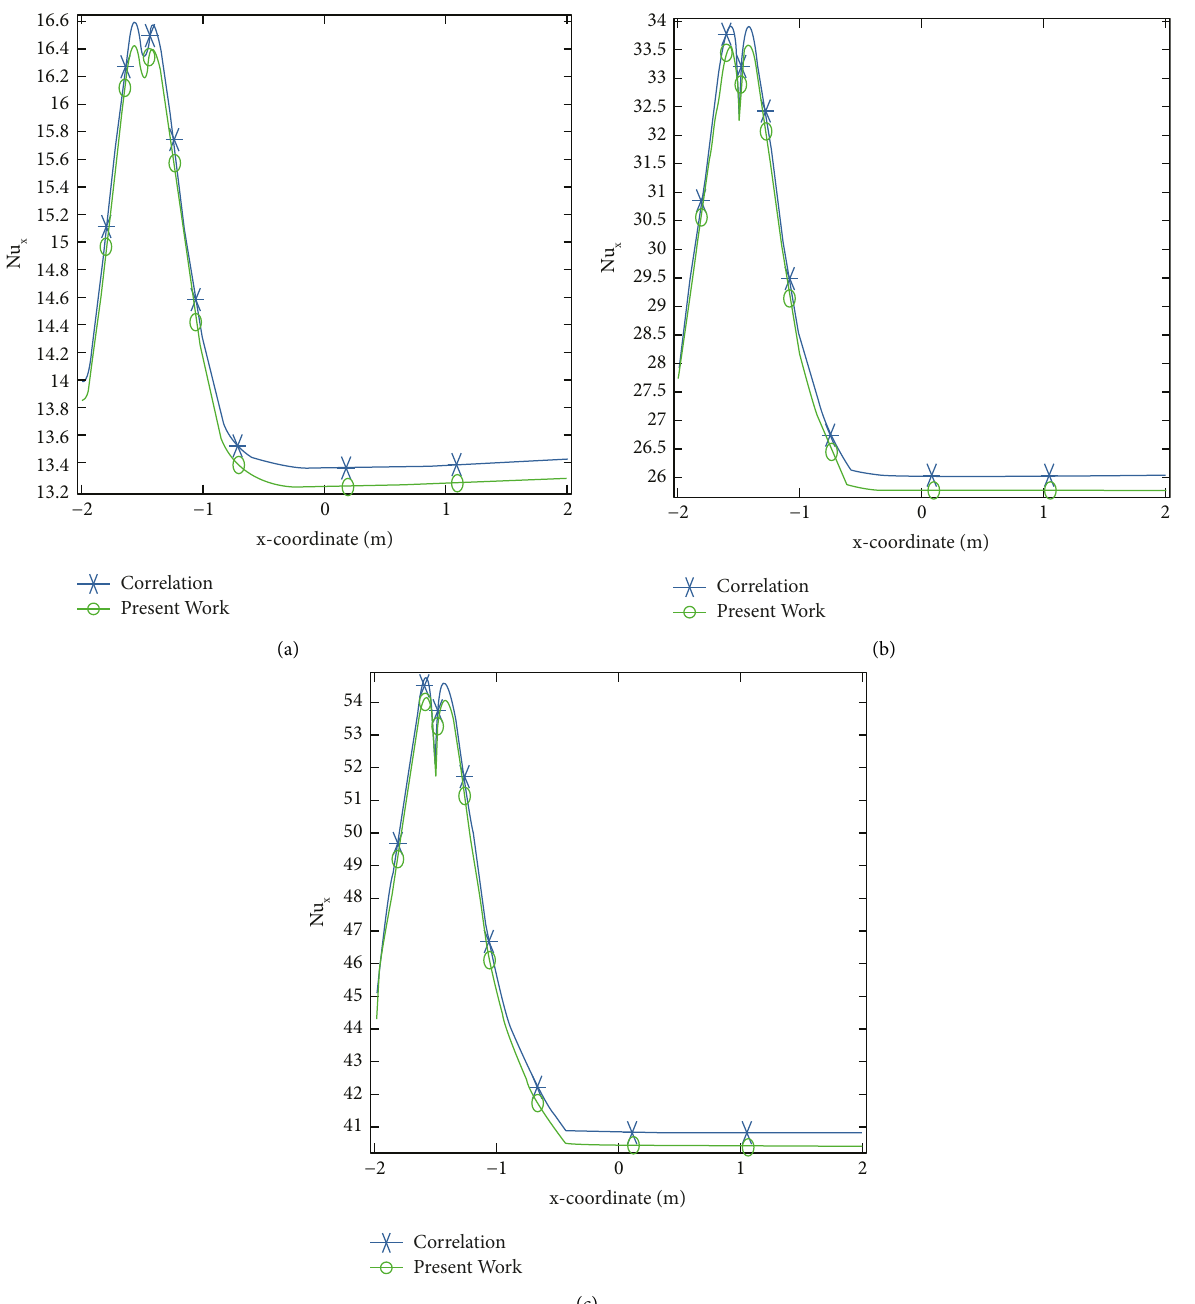
Figure 5: The comparison of local Nusselt number’s correlation with the present work: (a) Re � 1000, r � 0.2, and n � 0.8; (b) Re � 4000, r � 0.2, and n � 0.8; (c) Re � 10,000, r � 0.2, and n �